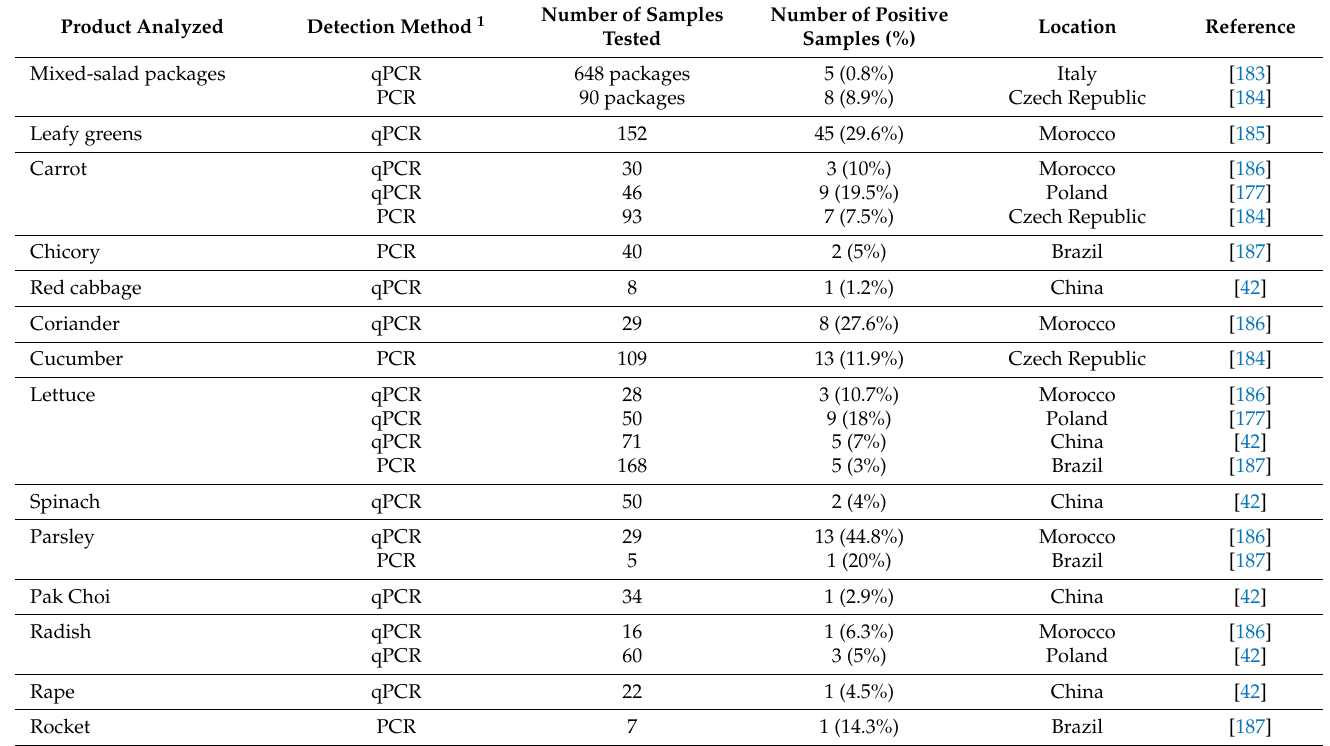
Table 4. T. gondii in fresh products and vegetables. The table shows the product that was analyzed, country of contamination, method used for detection, and prevalence that was